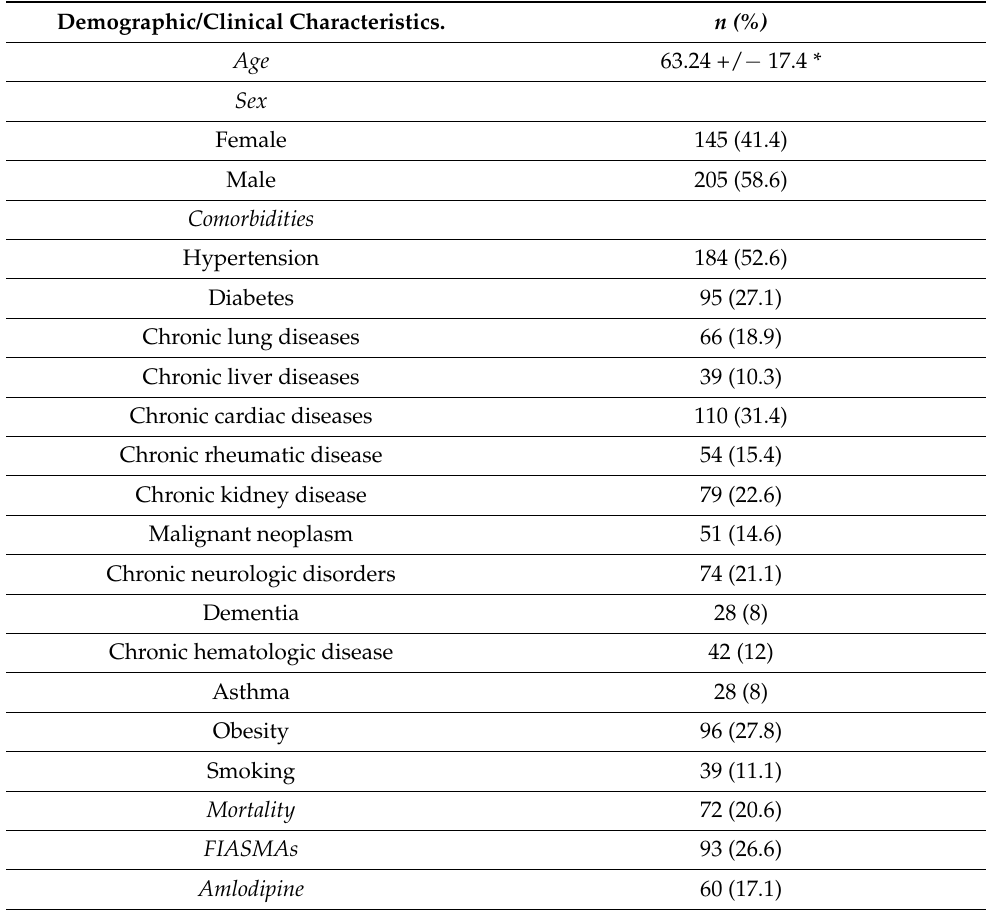
Table 1. Demographic and clinical characteristics of COVID-19 patients ( n = 350). Demographic/Clinical